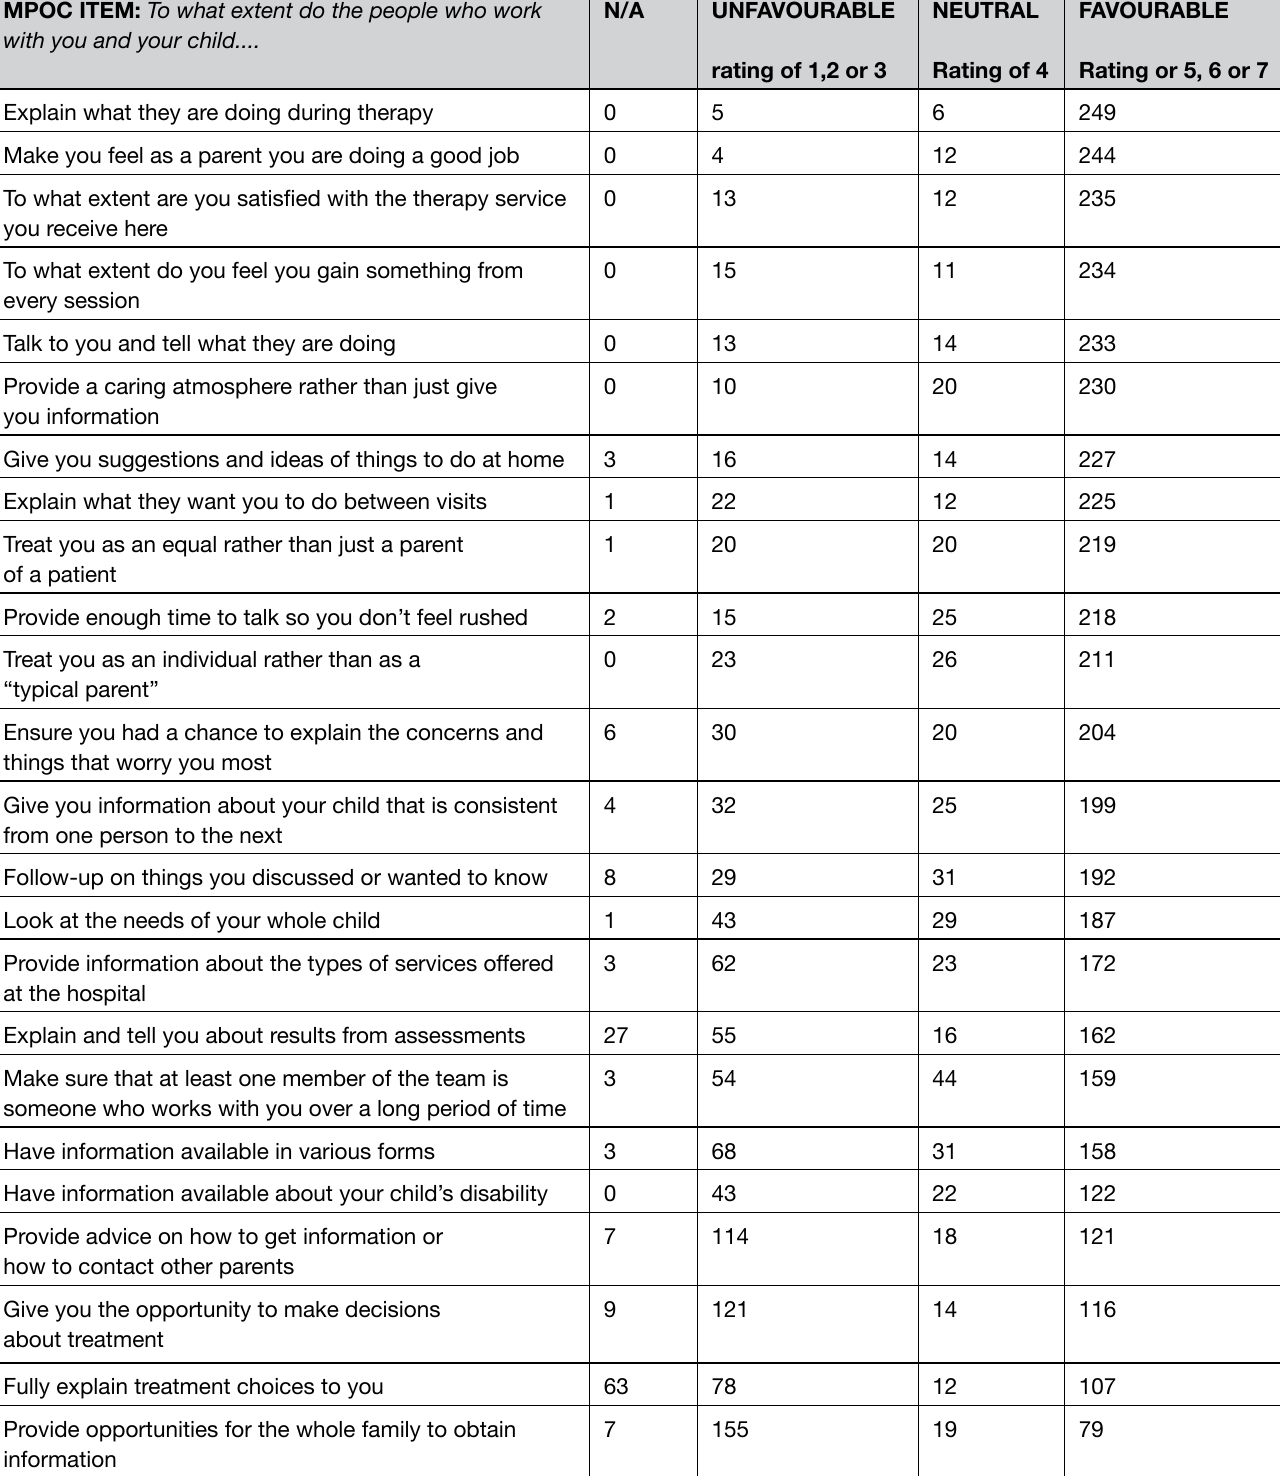
Table 3: Caregiver’s responses to the MPOC items (number of respondents, n = 260) Mpoc ITeM: To what extent do the people who work with you and your